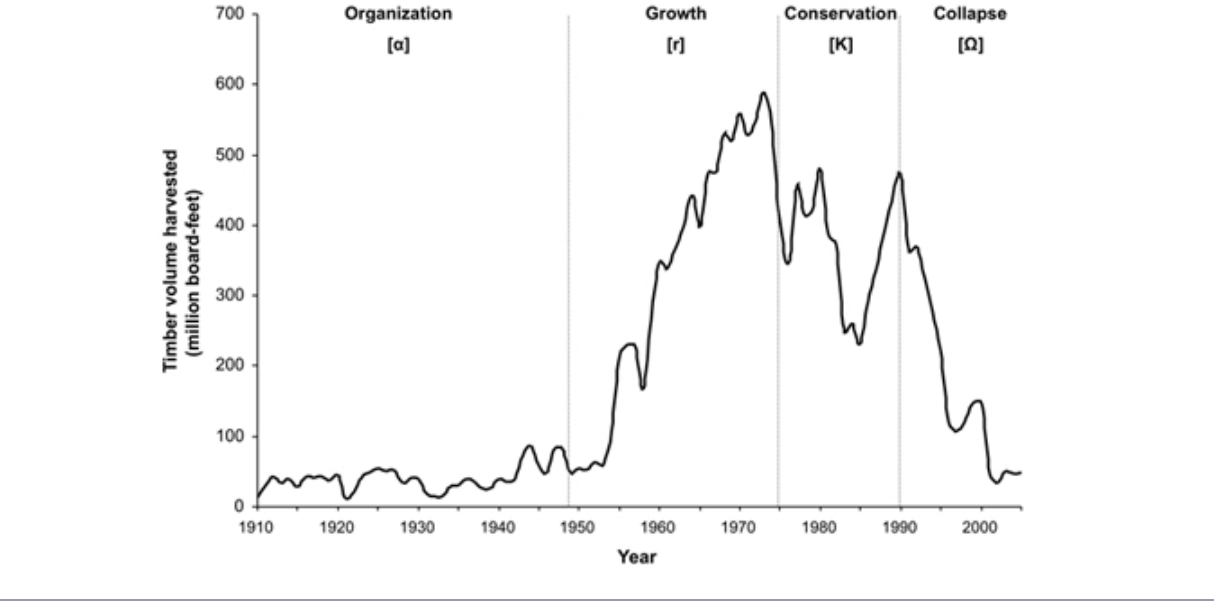
Fig. 1 . Tongass National Forest harvest outputs from 1910-2005, divided into four stages of the adaptive cycle, as described in Beier et al.